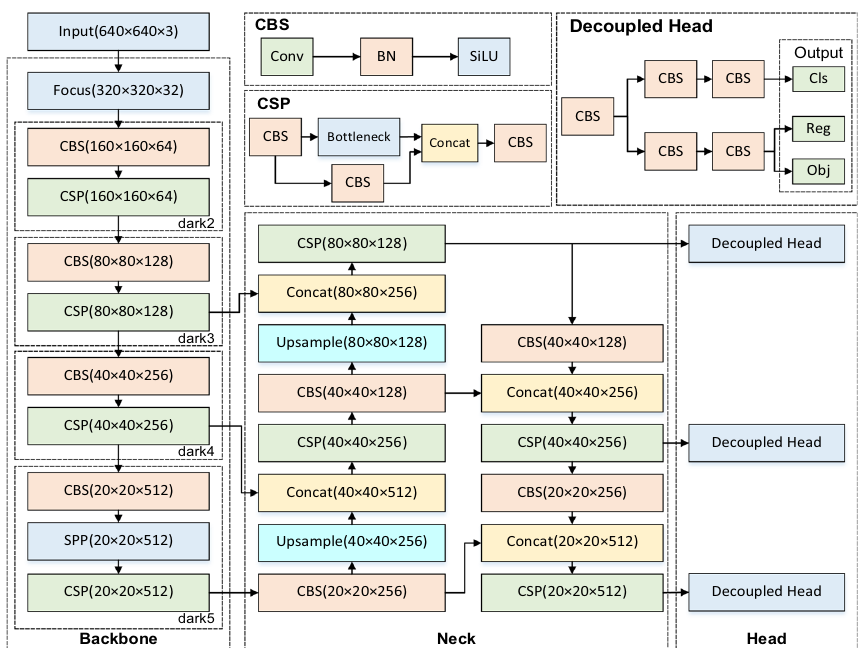
Fig. 3 YOLOX-S network